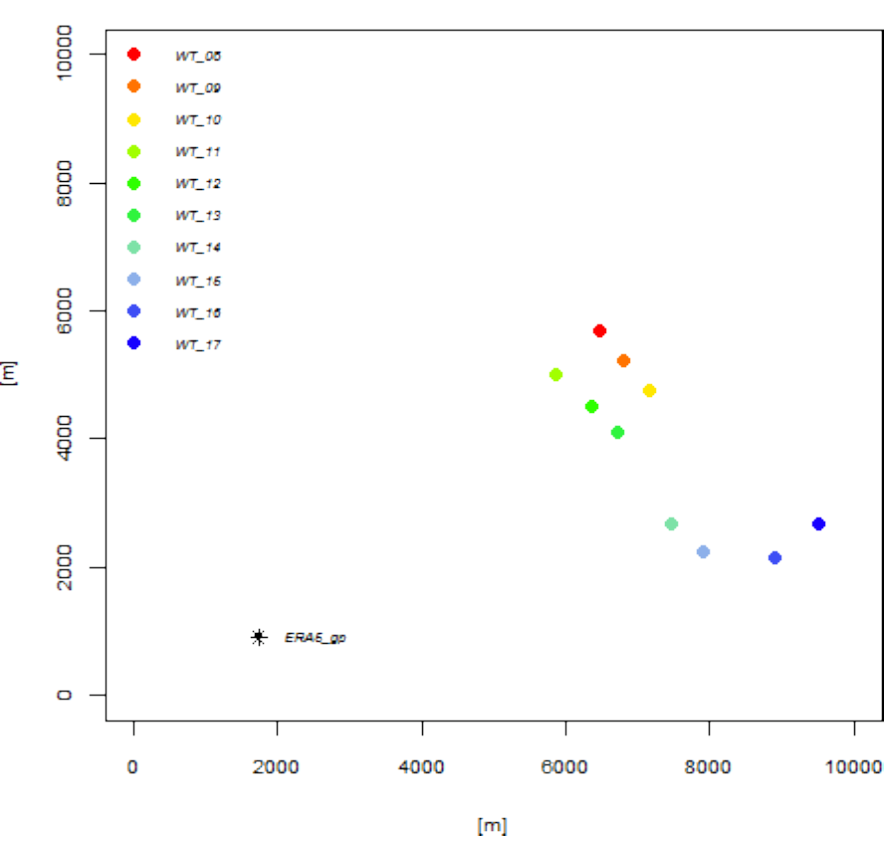
Figure 2. Layout of the wind farm and the position of the nearest ERA5 grid